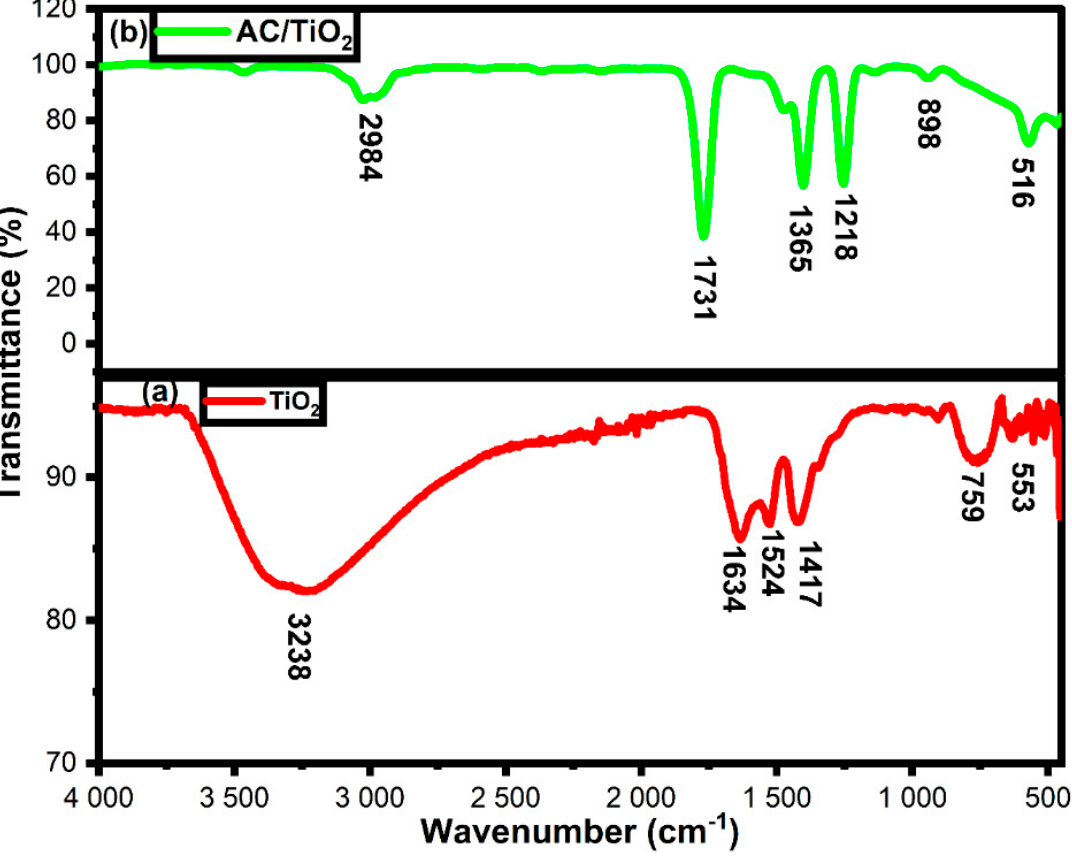
Figure 2. FTIR spectrum of TiO 2 (a) and AC/TiO 2 (b)